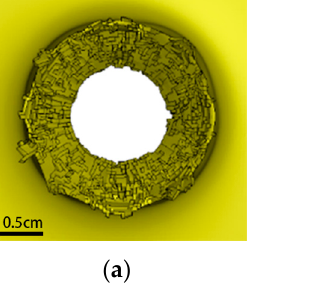
Table 5. Numerical simulation results and test results.